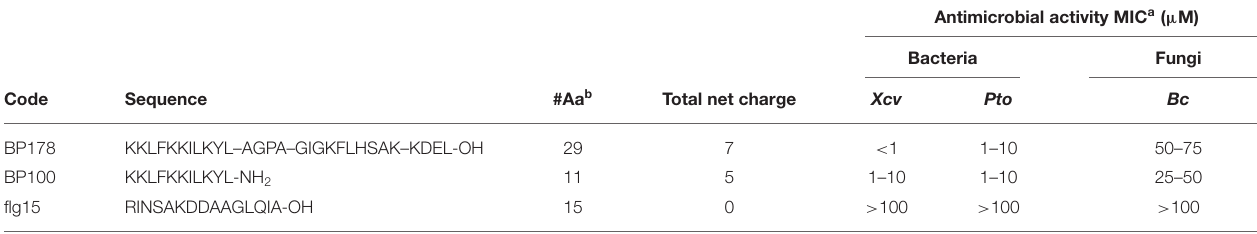
TABLE 2 | Sequence, number of amino acids, charge, and antimicrobial activity of the peptides used in this study.